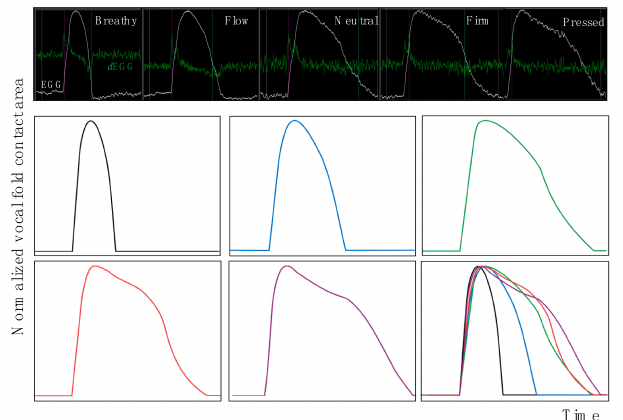
Figure 7. Electrolaryngograph (EGG) shapes displayed by the VoceVista Video Pro software for a single vibratory cycle of a male singer sustaining the vowel /a/ with the indicated phonation types. The top panel shows EGG shapes with their corresponding derivative (dEGG) for the indicated phonation types. In the middle and lower panels, the waveforms of the indicated phonation types are shown with greater detail, with normalized amplitudes and differentiated by colored lines for comparisons.